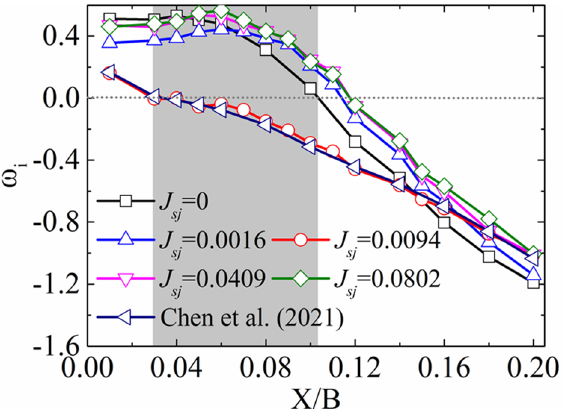
Figure 14. The imaginary part of the critical point at various positions (X/B) for different test cases.